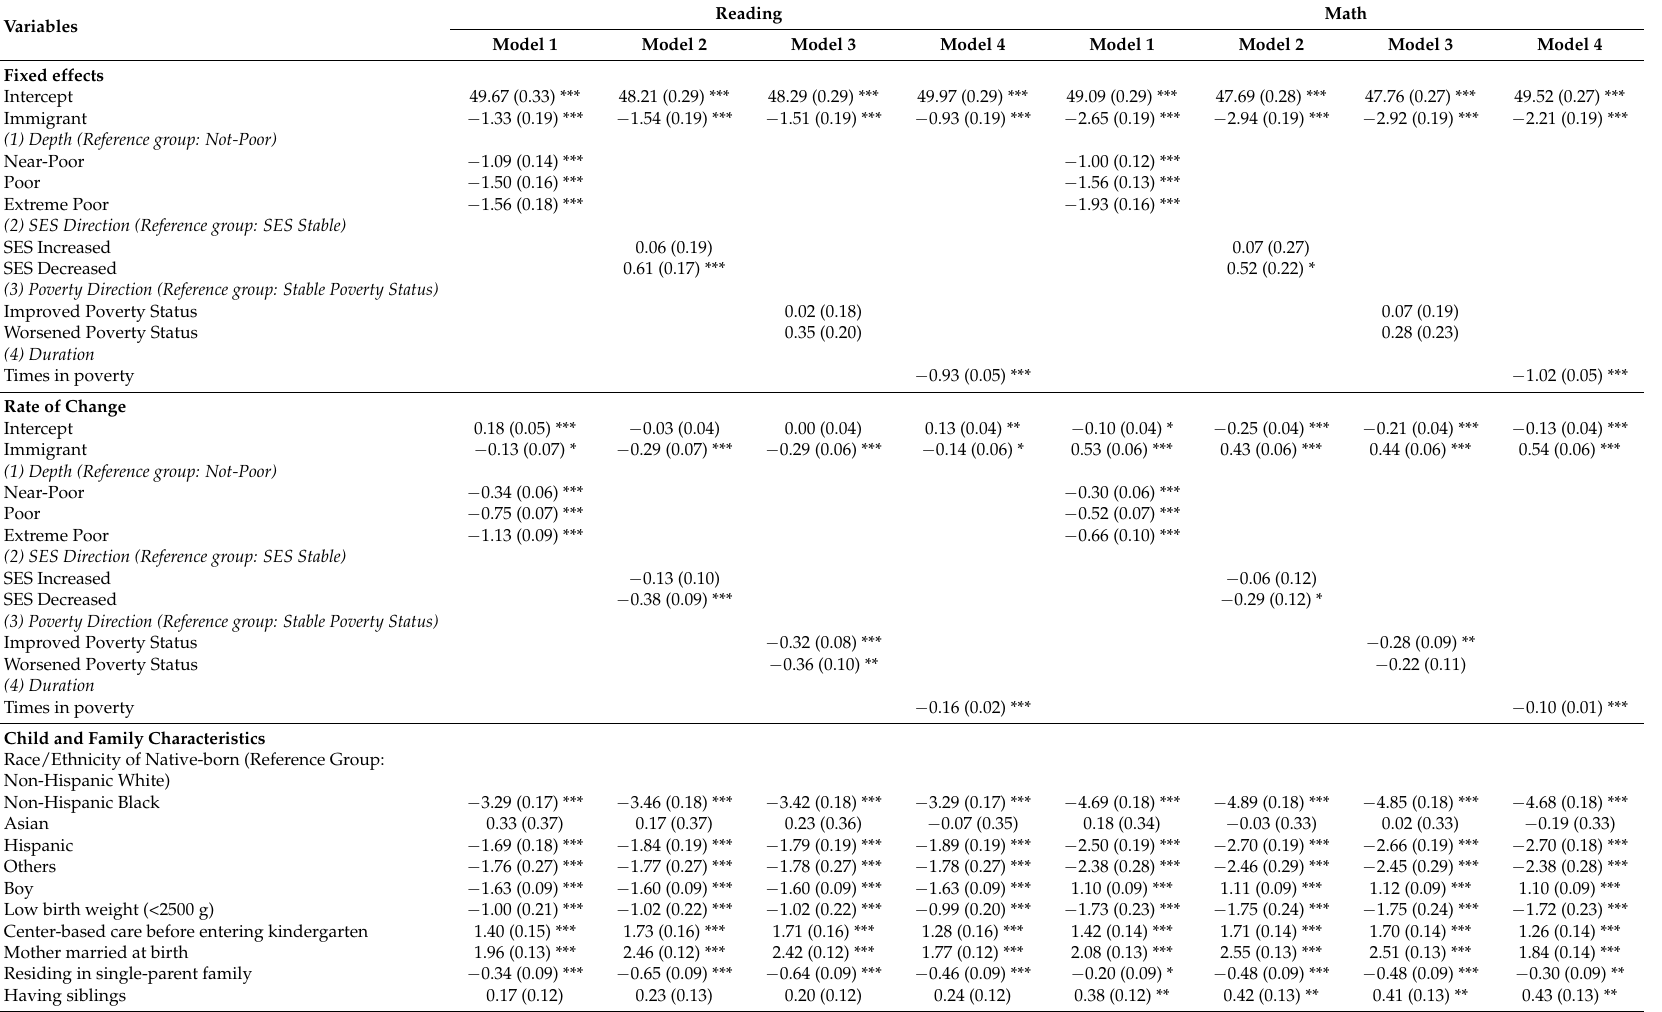
Table 4. Growth-curve results of academic achievements from kindergarten to eighth